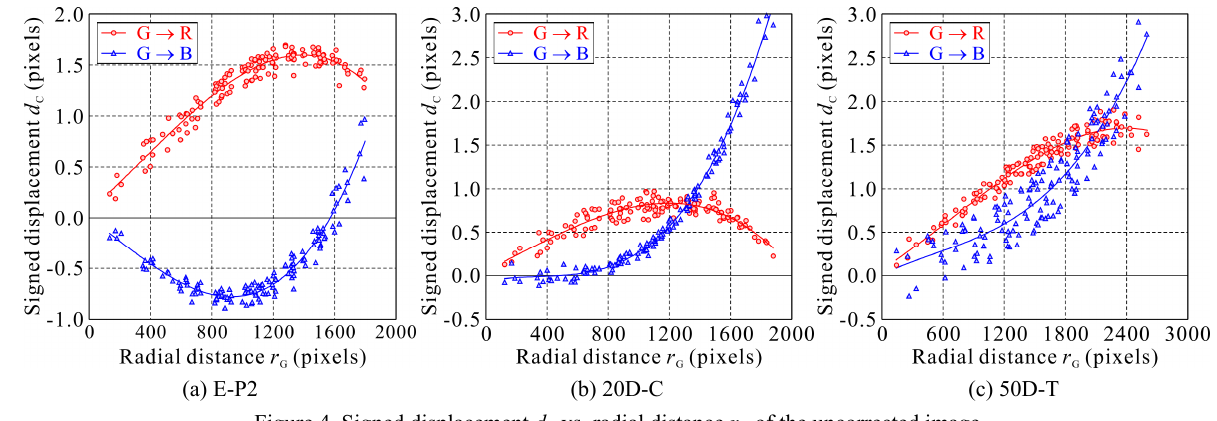
Figure 4. Signed displacement d C vs. radial distance r G of the uncorrected